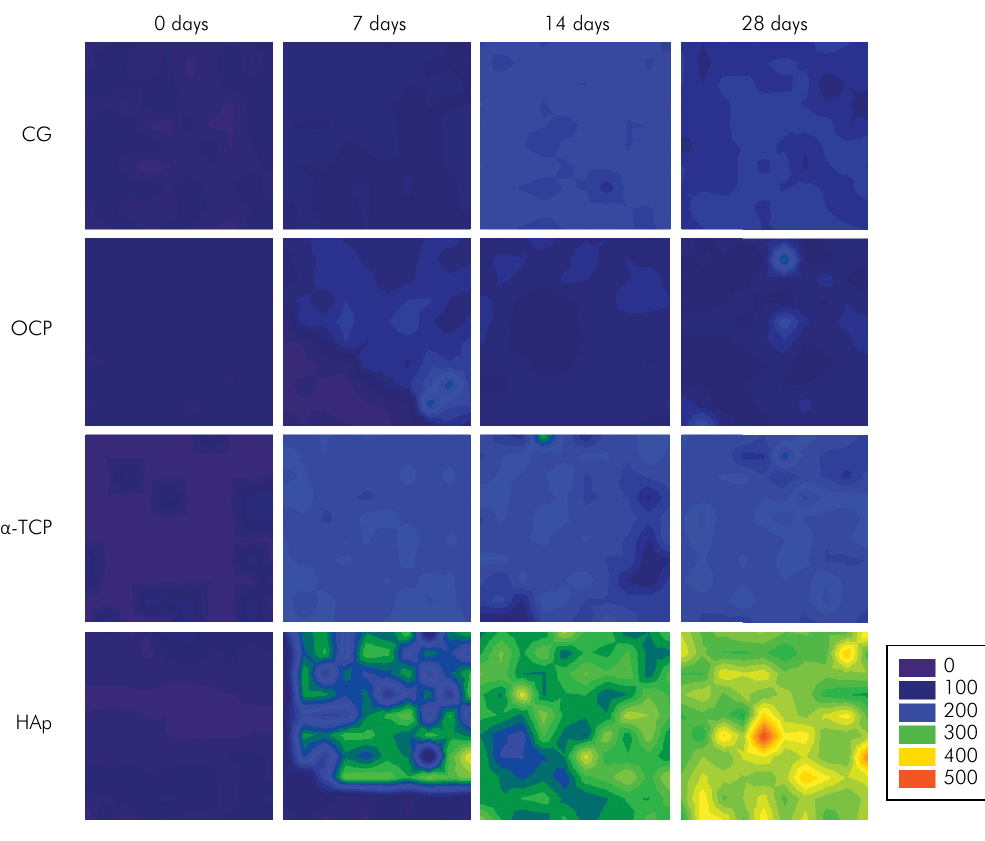
Figure 1. Color representation of the intensity of phosphate peaks (960 cm −1 ) in the different tested groups after 7, 14 and 28 days of immersion in saliva. Higher intensities are represented by red/green. Blue regions represent lower or total absence of phosphate